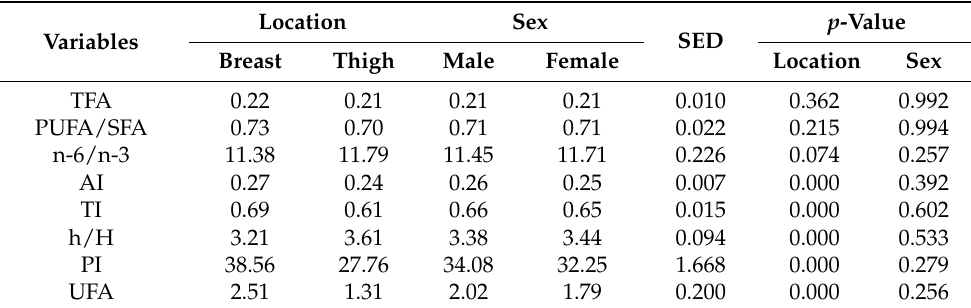
Table 11. Total trans fatty acids and fatty acid ratios and lipid quality indexes in intramuscular fat of goose meat. Location Sex Variables Breast